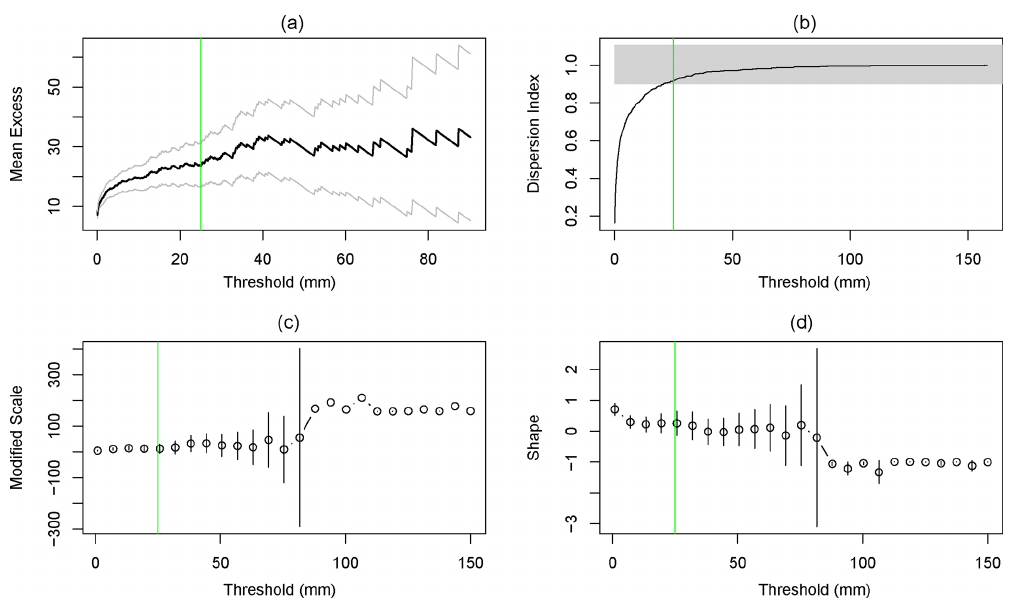
Figure A1. Graphical summary of RE threshold ( µ ) selection in Algeciras: (a) mean residual life: mean value of observations over a threshold (mean excess). (b) Dispersion index. (c, d) Scale and shape parameter estimates from the GPD for a range of values of µ . Green line represents the µ (25mm) selected, implying a higher variability of its exceeding values in (a) , (c) , and (d) and posing a limit in (b) from which dispersion index estimates are near the theoretical value 1.